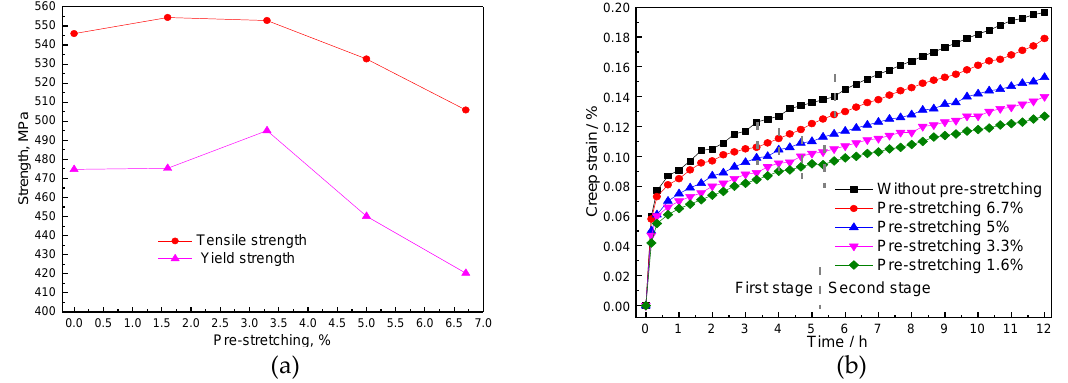
Figure 5. Variations of ( a ) tensile strength and yield strength against pre-stretching after creep-aging, and comparisons of ( b ) creep strain curves between pre- and non-stretched 7055-T6 alloys at 155 °C with a stress level of 190 MPa.